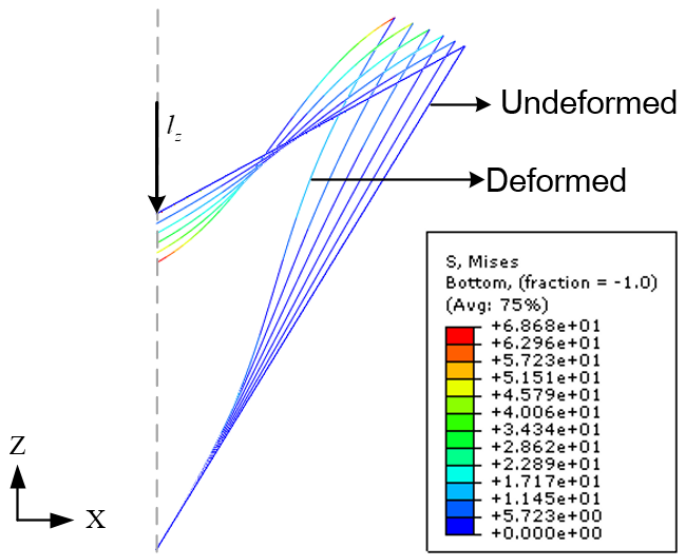
Figure 8. The deformation process of half a unit cell.